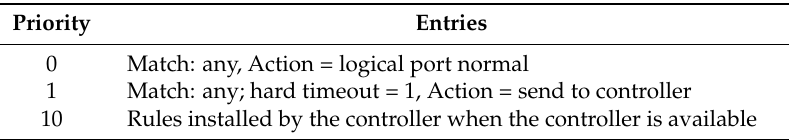
Table 2. Rules in traditional